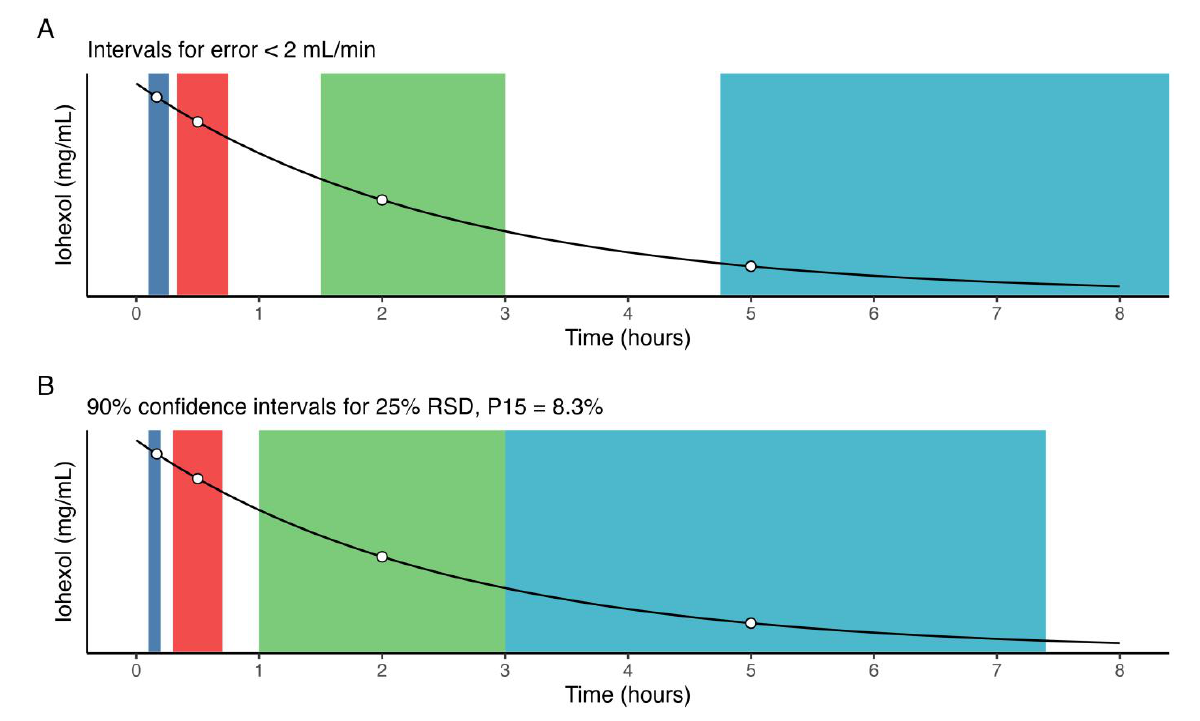
Figure 5. Empirical estimates of optimal sample windows for ( A ) deviations in individual sample times, assuming all other points are sampled optimally, resulting in mean error < 2 mL/min, and ( B ) deviations across all sample times, normally distributed around each sample point with 25% RSD, resulting in a P15 = 8.3%.